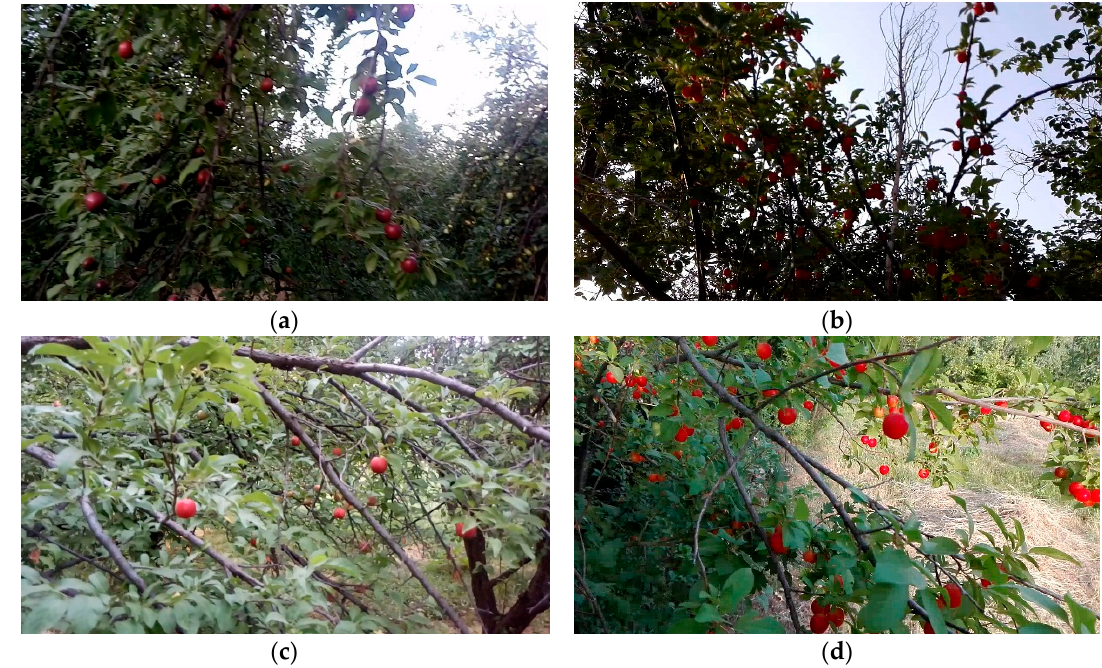
Figure 1. Four sample frames at different light intensities: ( a ) 467 lux, ( b ) 639 lux, ( c ) 826 lux, ( d ) 1848 lux.